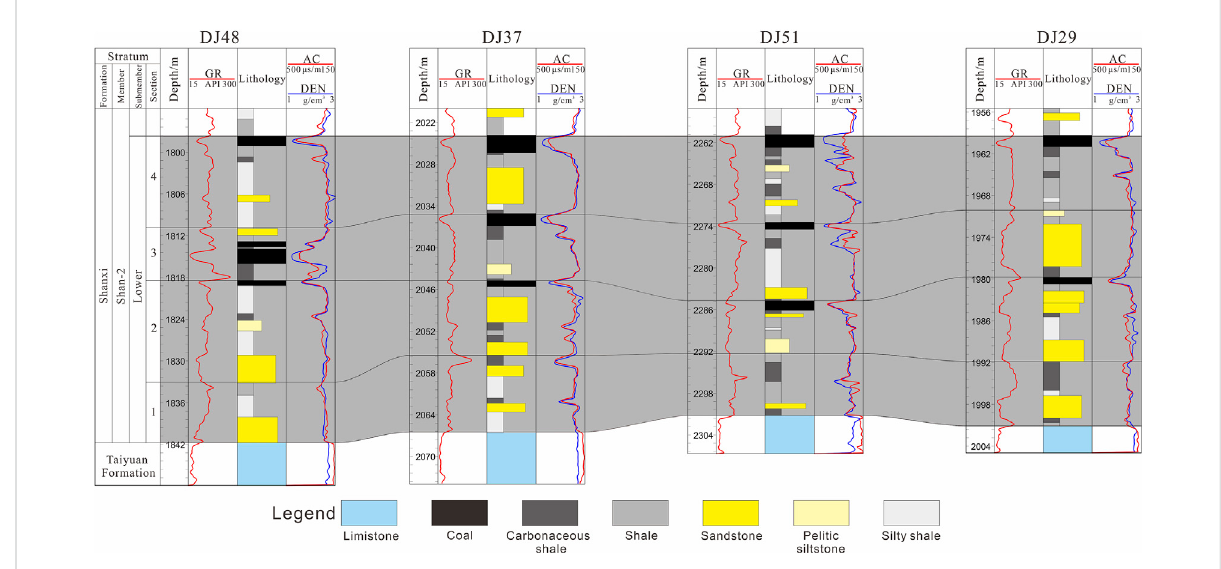
FIGURE 2 Stratigraphic correlation of connecting wells of the Shan-2 Lower Sub-member in the eastern Ordos Basin.